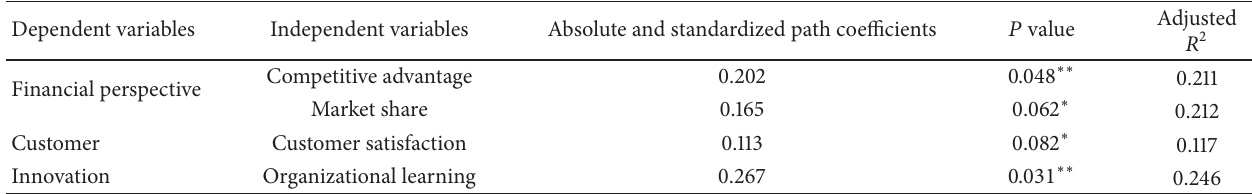
Table 7: Path analysis between 13 extracted CSFs and 4 performance perspectives. (Small technology-based firms expended by diversified products.)